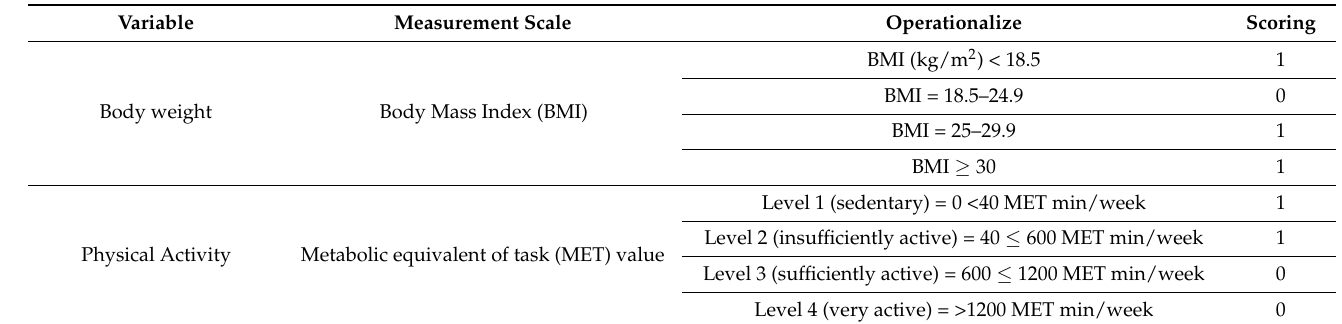
Table 1. Modifiable risk factor